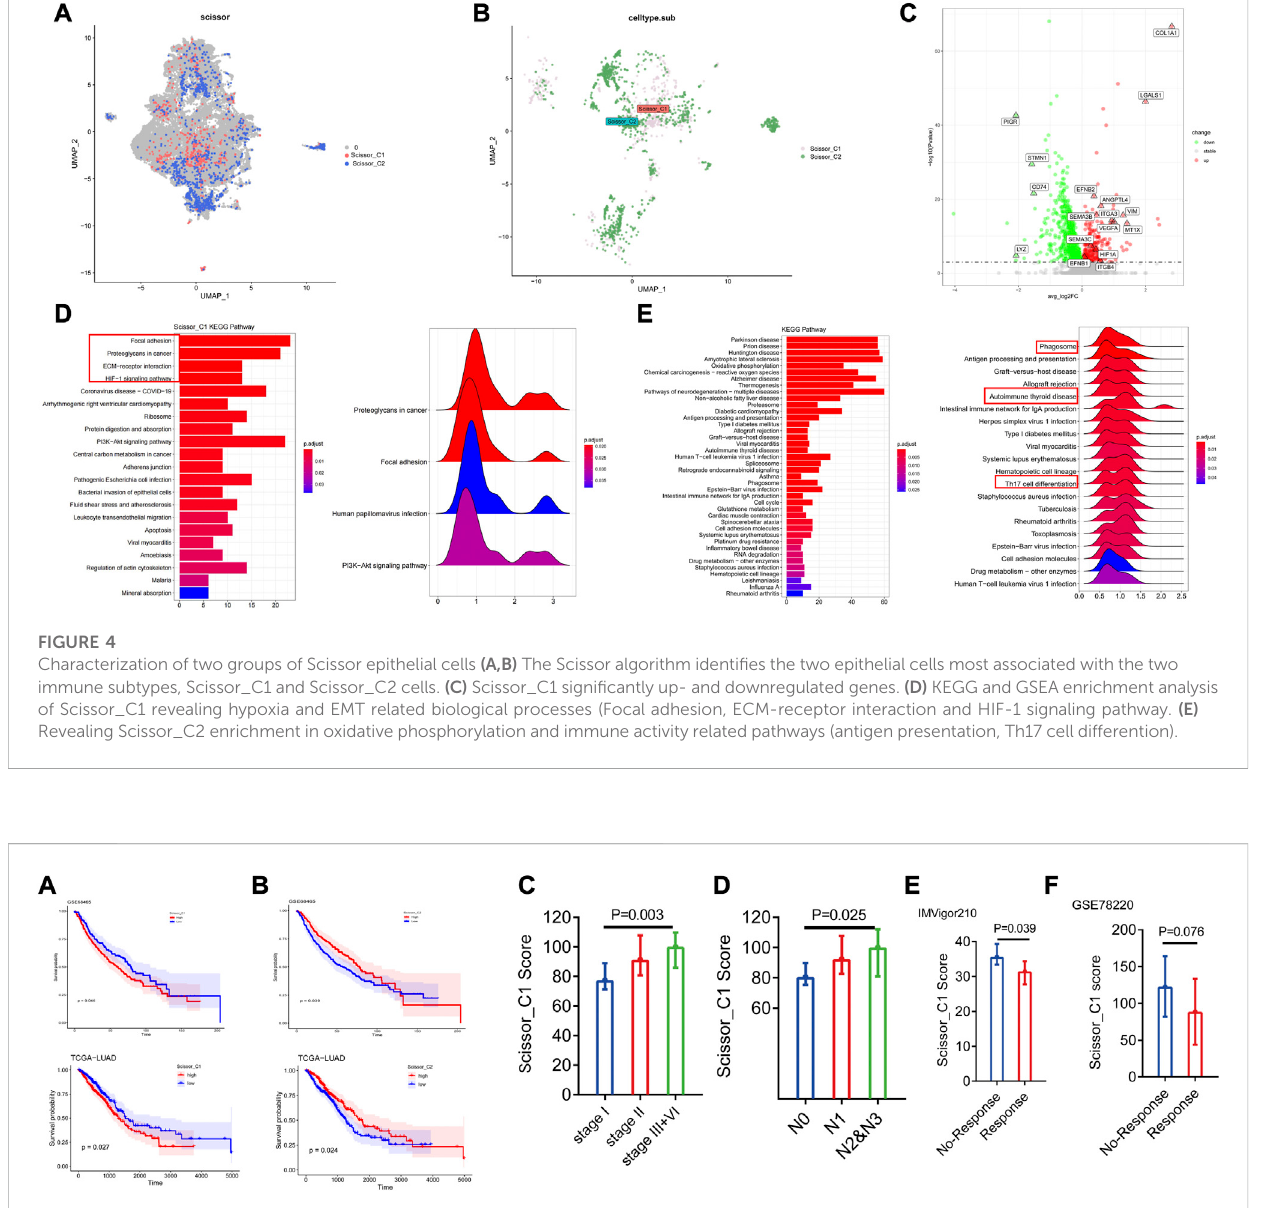
FIGURE 5 (A,B) Prognostic analysis of two groups of Scissor cells deconvoluted to bulk sequencing (C,D) Scissor_C1 cells exhibit different abundance in stage and N-stage deconvolution. (E,F) Scissor_C1 was highly expressed in the immunotherapy non-responsive group.